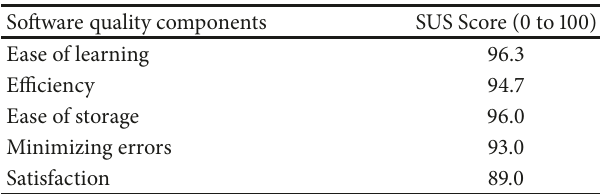
Figure 15: Teaching facial expressions, anger. Table 1: Average SUS score referring to the quality components of the game